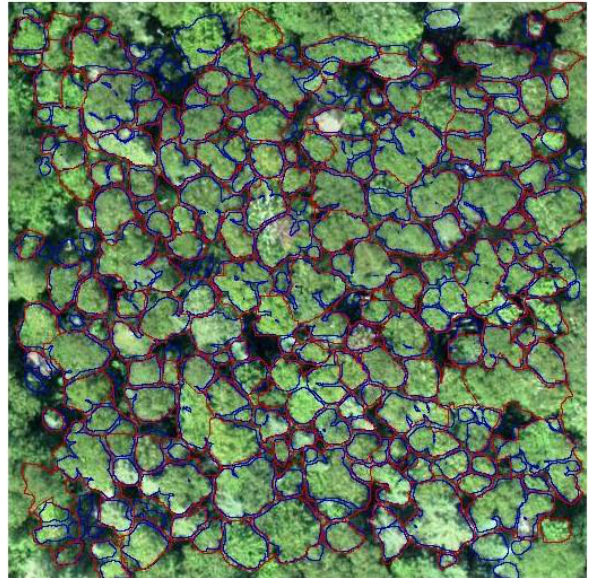
Figure 8 . ITC delineation result (blue circle) generated by Residual U-net, together with the tree crowns manually labelled (red circles) for the test size #2.